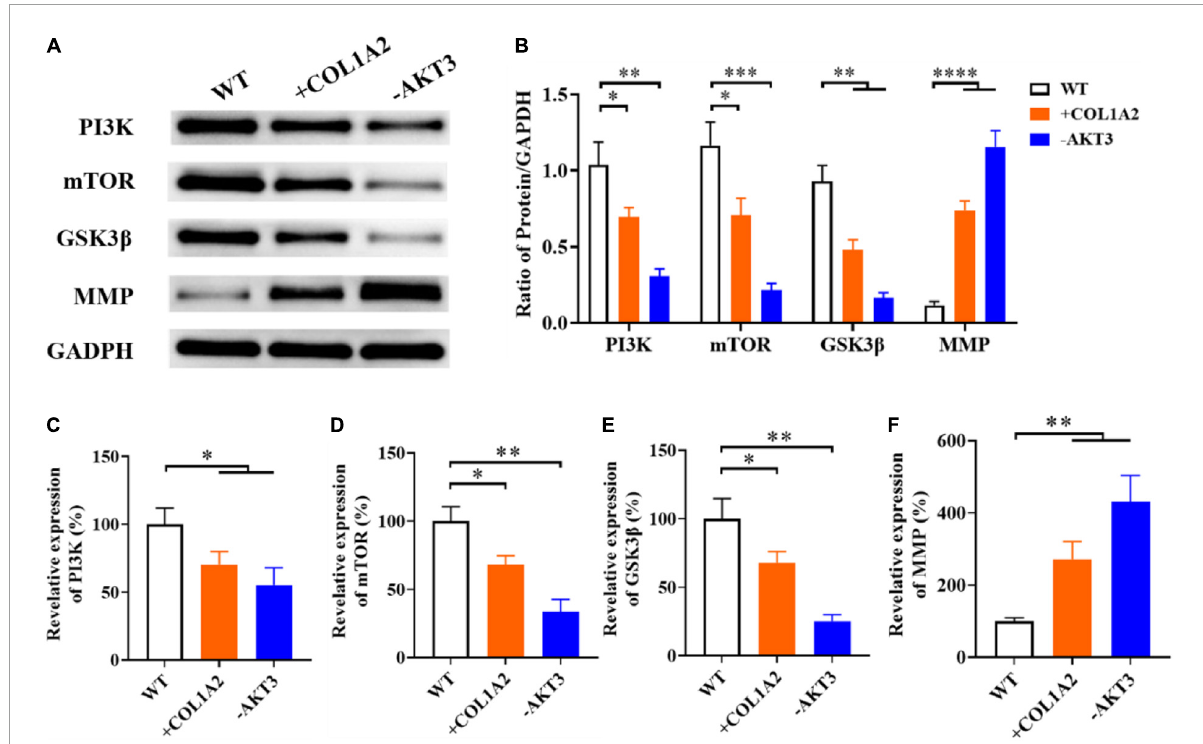
FIGURE4 The effects of the PI3K/AKT3 signal pathway in the CTEV. (A) Western blot of the expression of key proteins involved in the PI3K/AKT3 signal pathway. (B) Quantification of protein in panel (A) . qRT-PCR analyzation of plasma genes of PI3K (C) , mTOR (D) , GSK3 β (E) , and MMP (F) expression at the transcriptional level. Data are means ± SD ( n = 3). Statistical significance was determined using one-way ANOVA followed by Tukey’s test; ∗ p < 0.05; ∗∗ p < 0.01; ∗∗∗ p < 0.001; ∗∗∗∗ p <